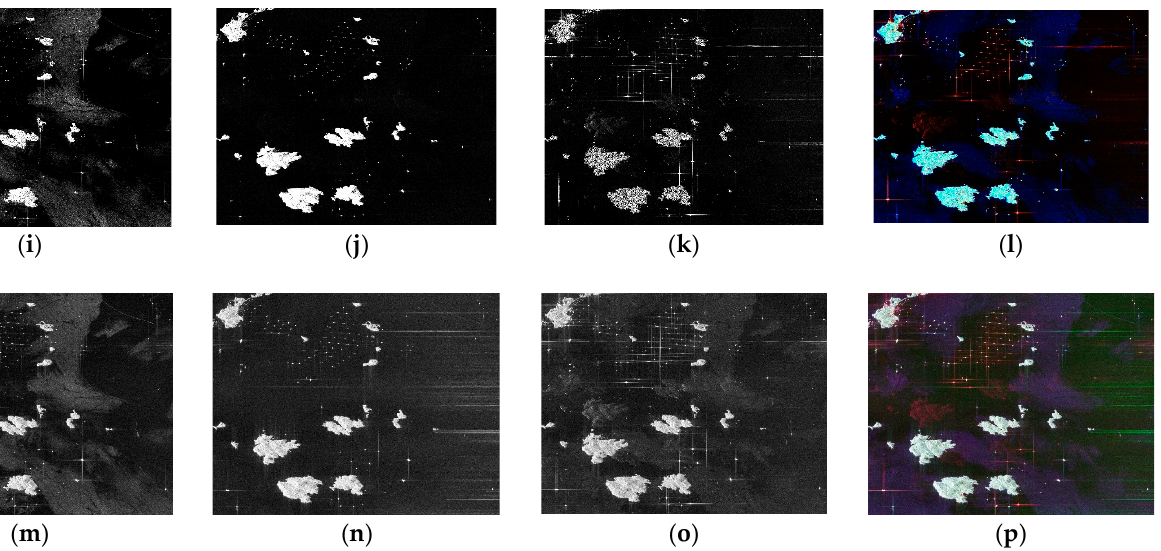
Figure 6. Extracting polarimetric features to build input data: ( a – c ) Pauli decomposition; ( d ) pseudo- color image of Pauli, each component of RGB corresponds to ( c ), ( b ), and ( a ); ( e – h ) Cloude decompo- sition; ( i – k ) Cui decomposition; ( l ) pseudo-color image of Cui, each component of RGB corresponds to ( k ), ( j ), and ( i ); ( m – o ) Adaptive filtering; ( p ) pseudo-color image of Adaptive, each component of RGB corresponds to ( o ), ( n ), and ( m ).